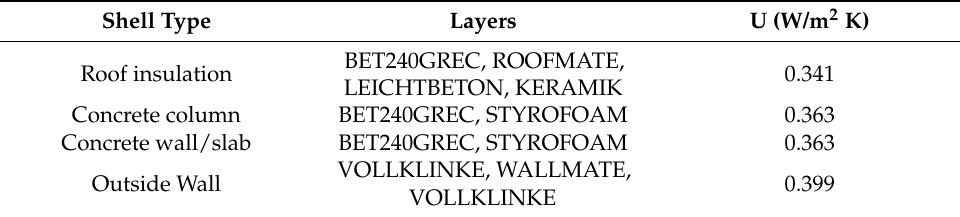
Table 1. Insulation data (U-values) for the building envelope (reinforced concrete structure).